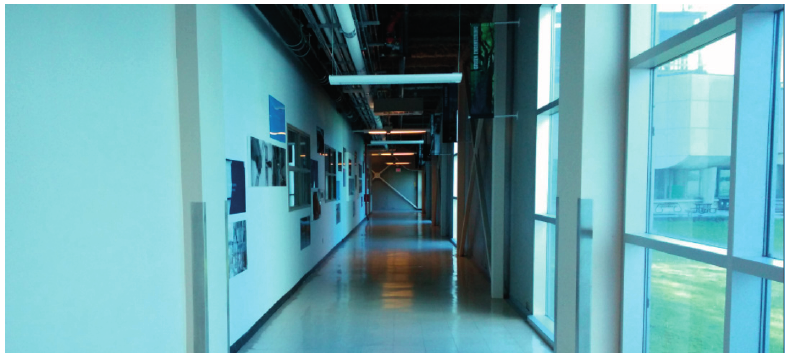
Figure 13. Indoor test environment at ENB.